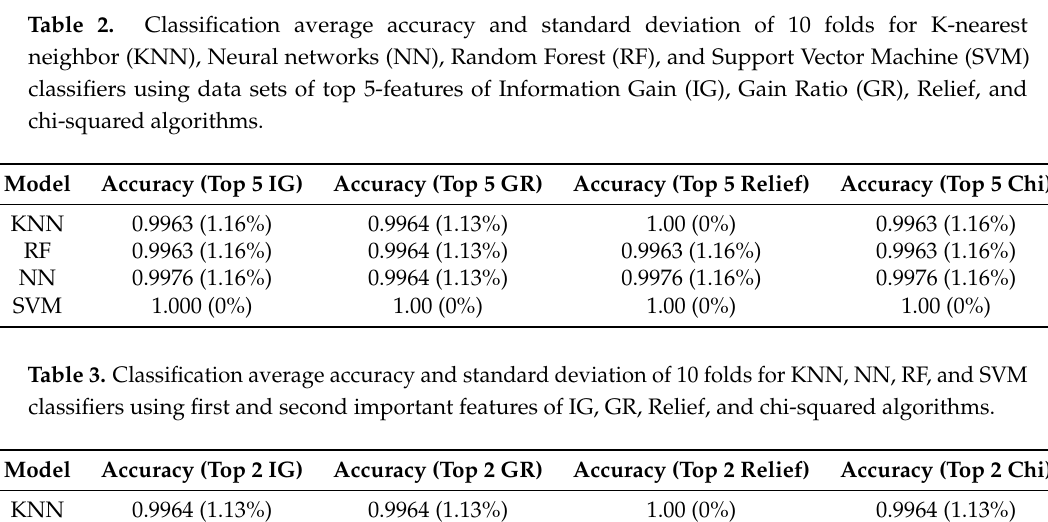
Classification average accuracy and standard deviation of 10 folds for K-nearest